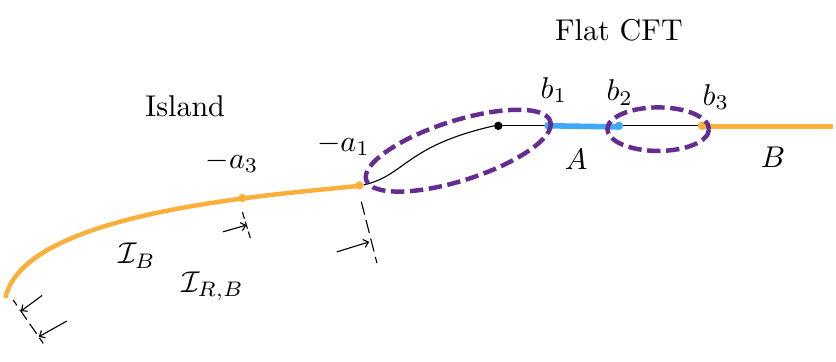
Figure 13 . Phase-D2 for JT gravity. The purple dashed circles denote the boundary gaps between A ∪ I R,A and B ∪ I